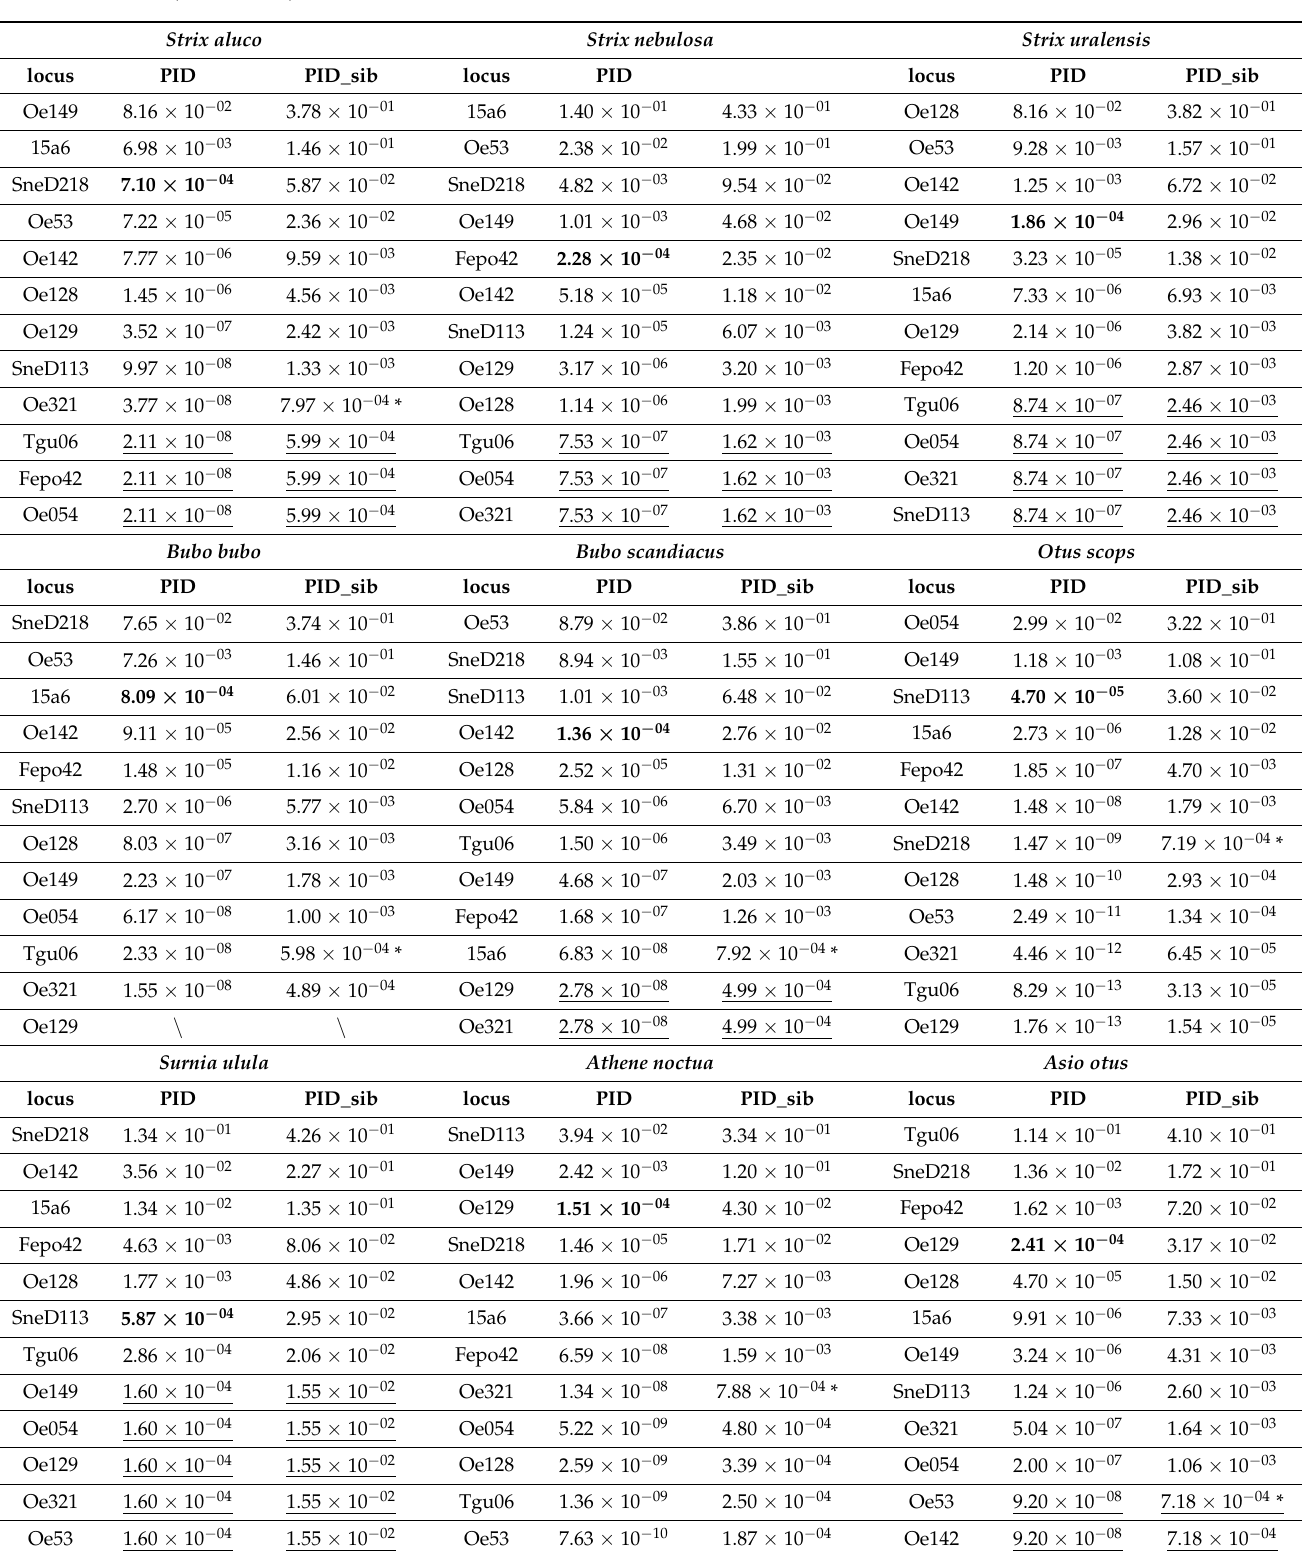
Table 4. PID and PID_sib values: In the table, values lower than 0.001 were bold-evidenced. In the PID_sib columns, this threshold wasindicated with (*). The PID_sib never reached this value in Surnia ulula (0.0155), Strix nebulosa (0.00162) and Strix uralensis (0.0246). When PID or PID_sib values stop decreasing it means that the markers are not variable and informative